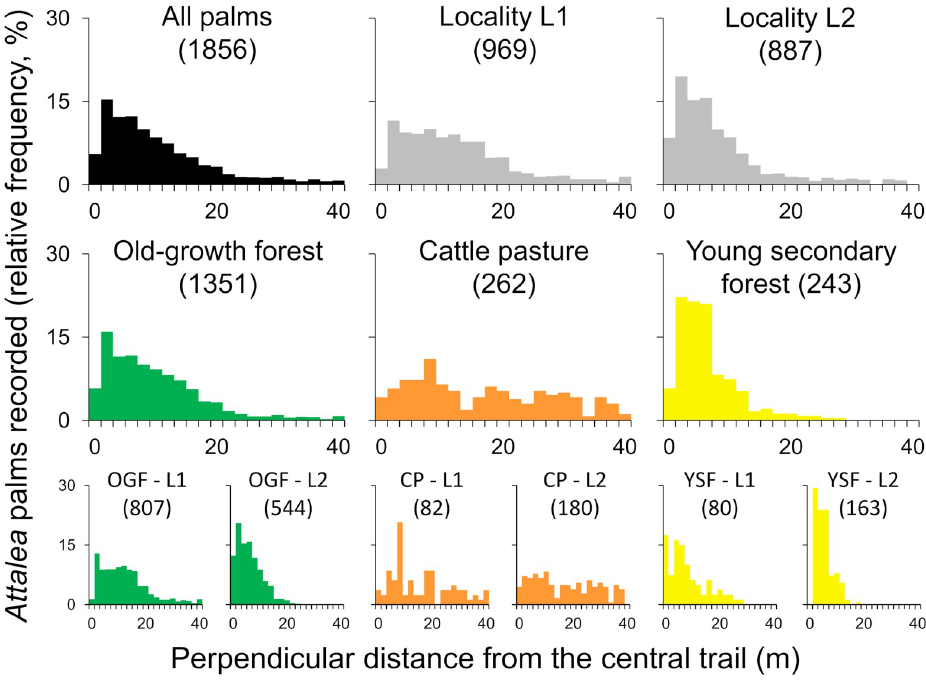
Fig 2. Attalea palm detections. The histograms show the relative frequencies of adult Attalea -palm detections (vertical axes, all scaled to a 30% maximum) as a function of perpendicular distance (horizontal axes; 0–40 m) from linear trails established in 10 transects representing three landscape classes in two eastern-Amazonian localities (“L1” and “L2”). The upper row shows overall and locality-specific results. Landscape class-specific results (middle row) show how detections clustered at shorter distances in young secondary forest (“YSF”), but were spread over all distances in deforested cattle pasture (“CP”); the pattern was somewhat intermediate for old-growth forest (“OGF”). The lower row shows results stratified by landscape class and locality. The number of palm detections used to build each graph is given in parentheses.